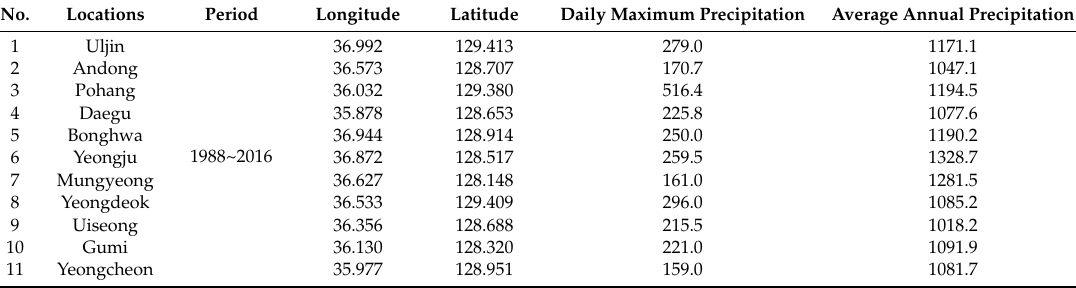
Figure 2. Location of rain gauge station in Daegu and Gyeongbuk (ASOS). Table 1. Summary of ASOS.